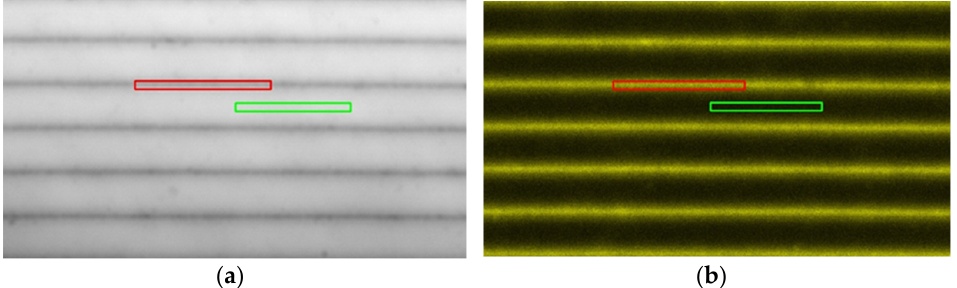
Figure 4. Transmitted light ( a ) and PL (( b ), real color) images of a hologram with a spatial period of 2.5 µm obtained using an LSM 710 laser scanning microscope with a 405 nm laser. The rectangular regions in the bright and dark stripes represent those for which the local PL spectra were measured (see the spectra below).